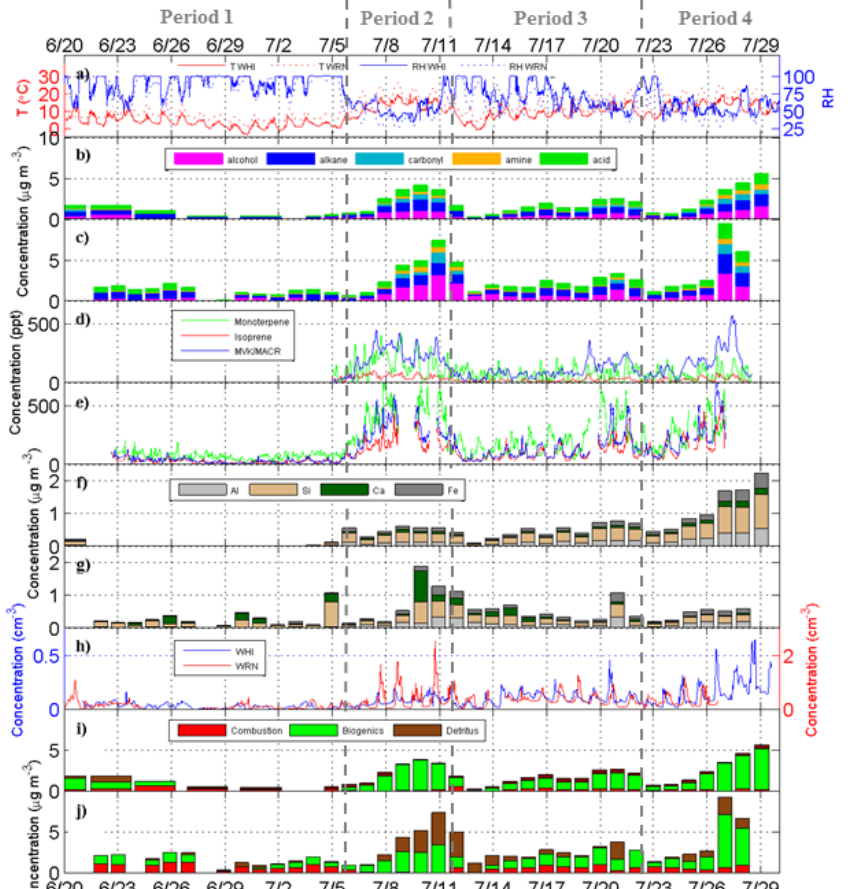
Fig. 2. Time series of temperature ( T ) and relative humidity (RH) (a) , FTIR organic functional groups at WHI (b) and WRN (c) , PTR-MS VOCs at WHI (d) and WRN (e) , XRF dust elements at WHI (f) and WRN (g) , coarse particle number concentrations (h) , and PMF factors Fig. 2 . Time series of temperature (T) and relative humidity (RH) (a), FTIR organic 1004 at WHI (i) and WRN (j) functional groups at WHI (b) and WRN (c), PTR-MS VOCs at WHI (d) and WRN (e), XRF 1005 dust elements at WHI (f) and WRN (g), coarse particle number concentrations (h), and PMF 1006 factors at WHI (i) and WRN (j). 1007